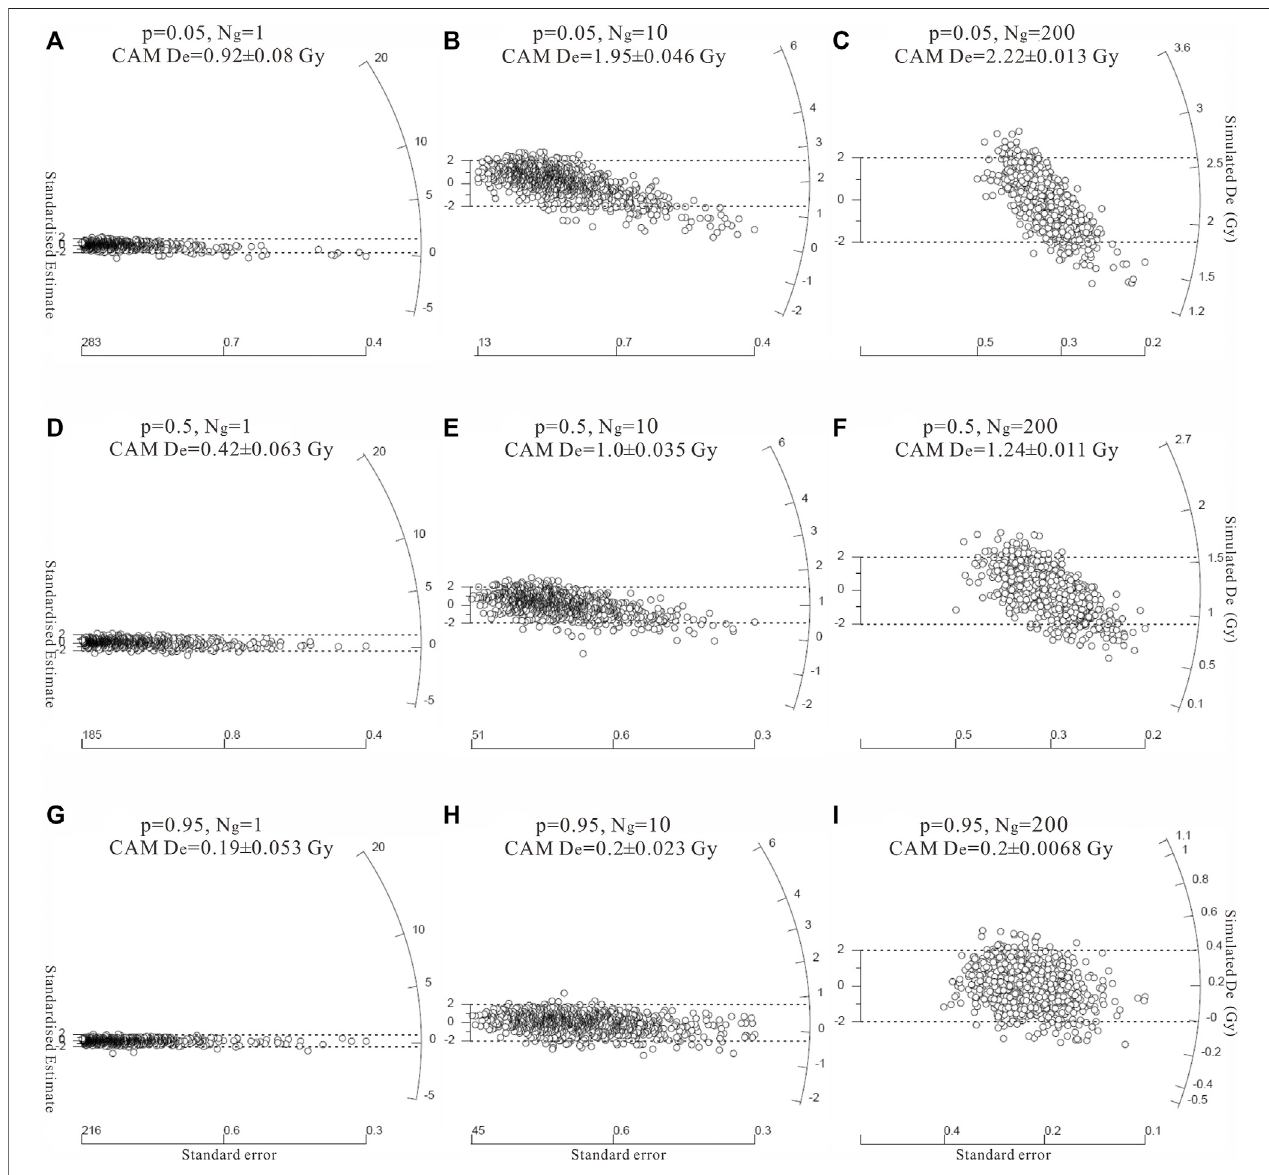
FIGURE6| D e distributions simulatedusingaburialdose of μ a =0.1 Gyandabaseline doseof μ q =10 Gy, fordifferentproportions offully-bleachedgrains( p )and different numbers of grains contained in an aliquot ( N g ). Each subplot consists of 1,000 D e values. The dashed lines indicate the two sigma range of the distribution.